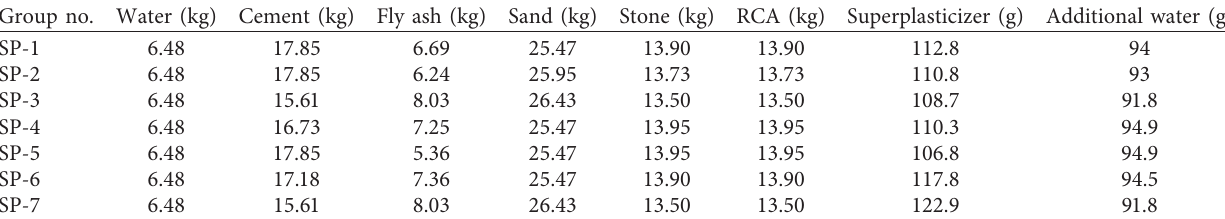
Table 5: Trial mix design.